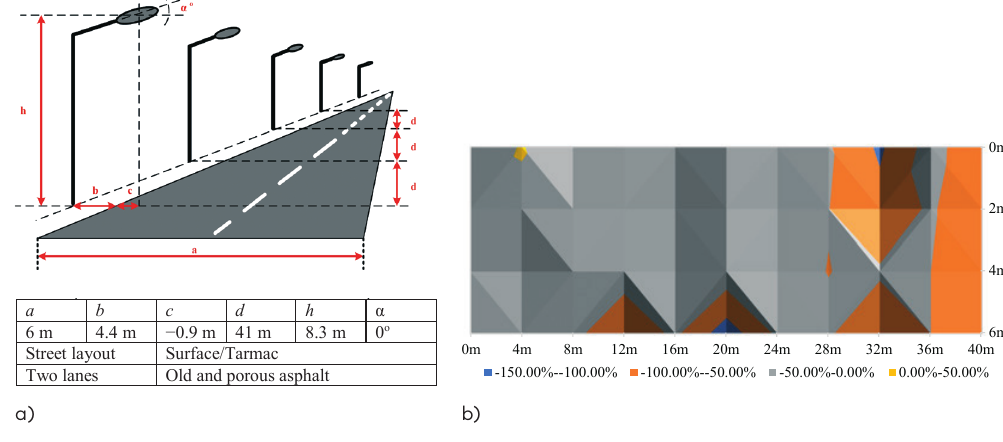
Figure 11. Incukalns city street comparison in 2012: a – street profile; b – comparative difference (%) between the measured and modelled street profile values